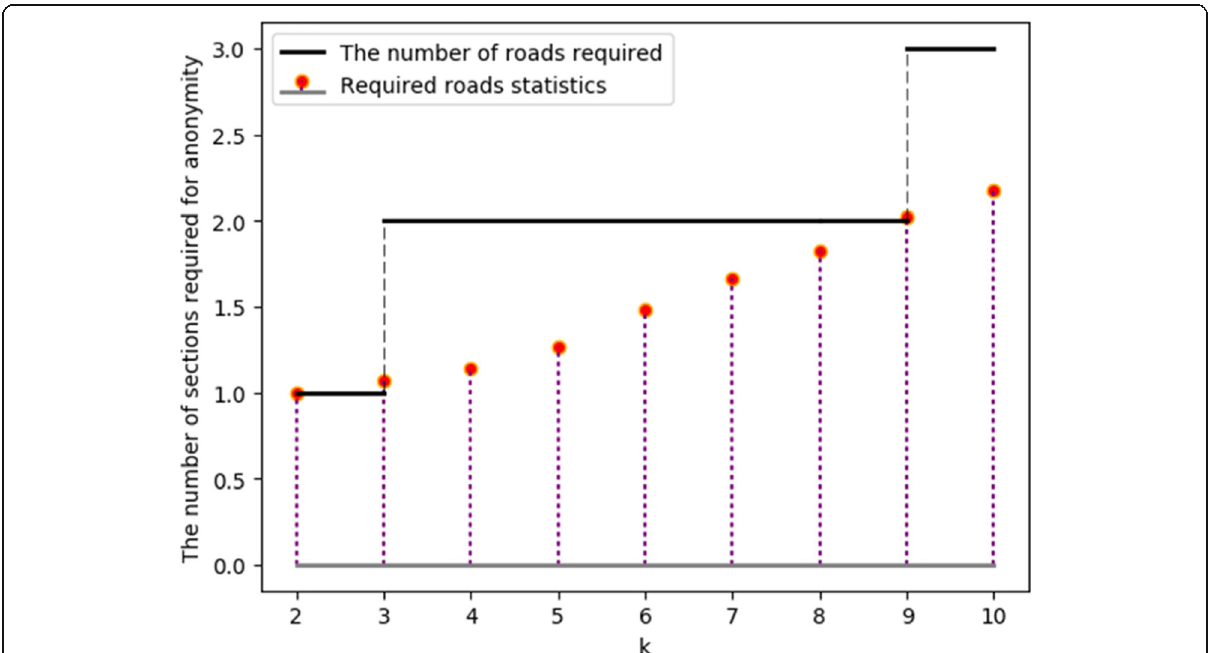
Fig. 11 The needed roads to complete anonymity of BL k -disturbance algorithm. As shown in this figure, the matchbox bar represents the statistical value of the number of roads that the user needs to complete anonymity under the different k -value